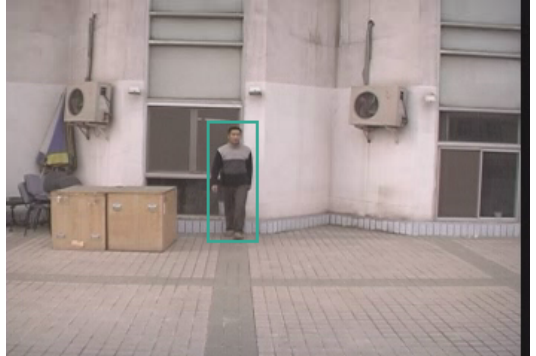
Figure 20. A 90° example from CASIA-A. The data name is lsl-90_1-006.png . The image size is 352 × 240 and the human subject size is 30 × 78.